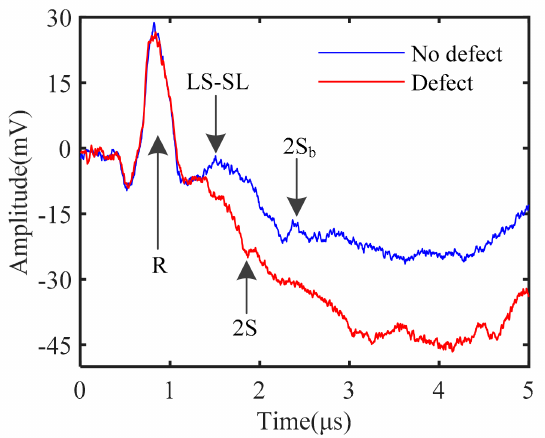
Figure 11. Experimental signals of laser ultrasound in the Cu/Al bimetallic specimen.